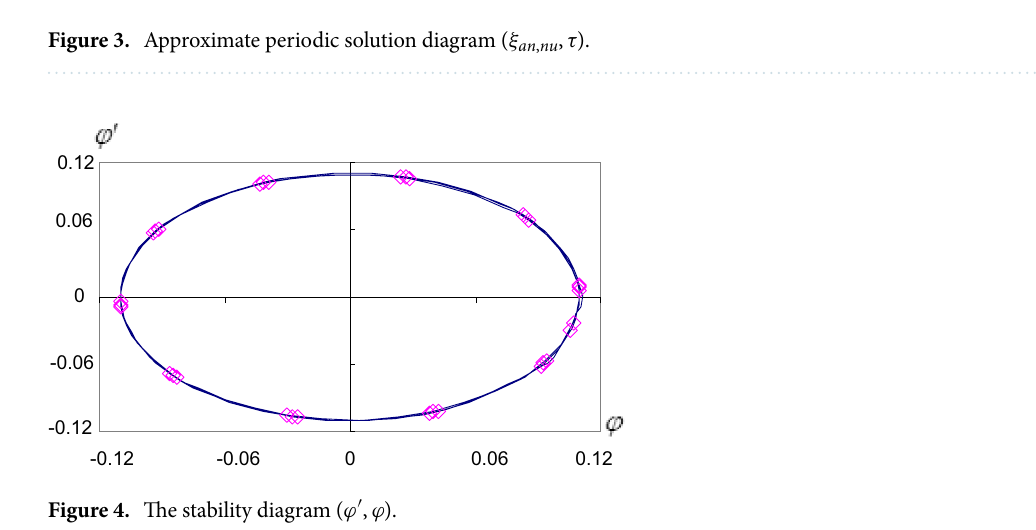
Figure 4. The stability diagram ( ϕ ′ , ϕ